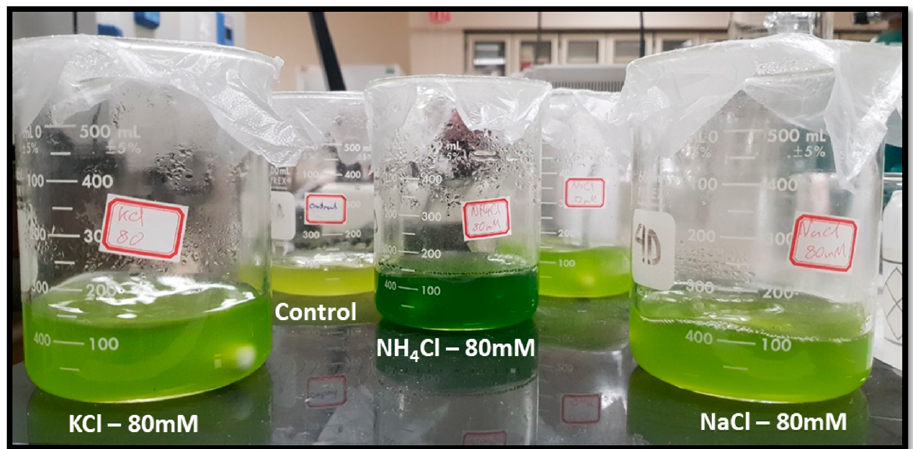
Figure 3. The visual effects of different salts (simulating RSF in a FO operation) on color changes of the C. vulgaris solutions. The picture was taken after 2 days of the addition of salts.